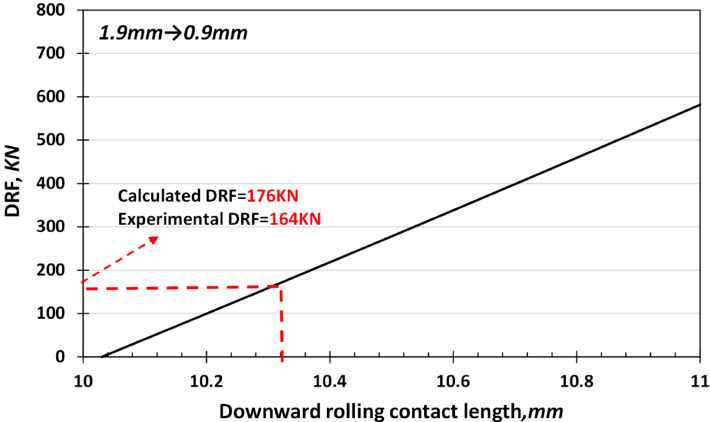
Figure 12. Predicted DRF values using slab method